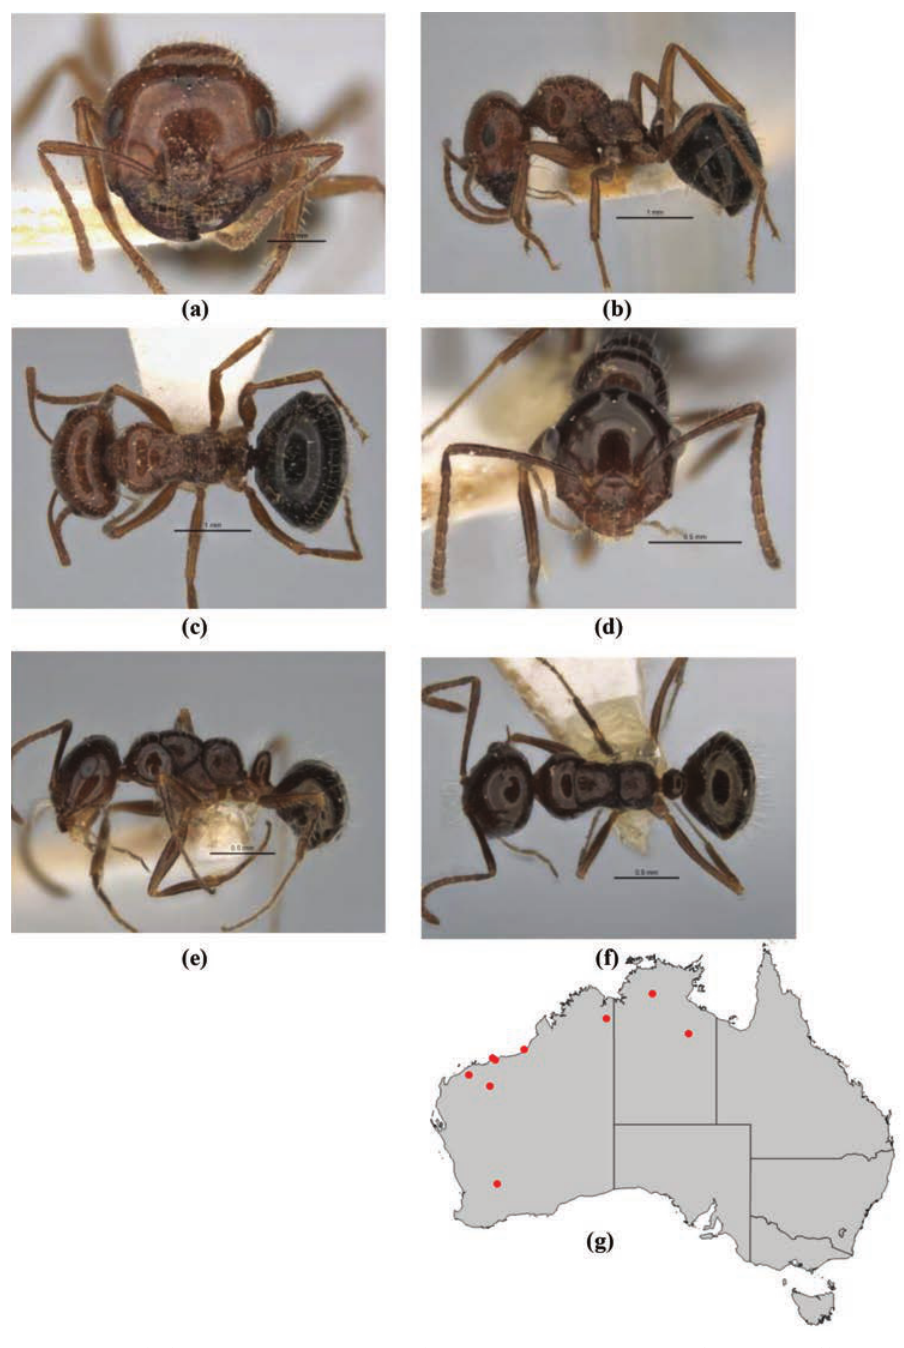
Figure 59. Melophorus incisus sp. n.: major worker paratype (JDM32-001996) frons ( a ), profile ( b ) and dorsum ( c ); minor worker holotype (ANIC32-900170–bottom ant) frons ( d ), profile ( e ) and dorsum ( f ); distribution map for the species ( g ). Low resolution scale bars: 1 mm ( b, c ); 0.5 mm ( a, d–f